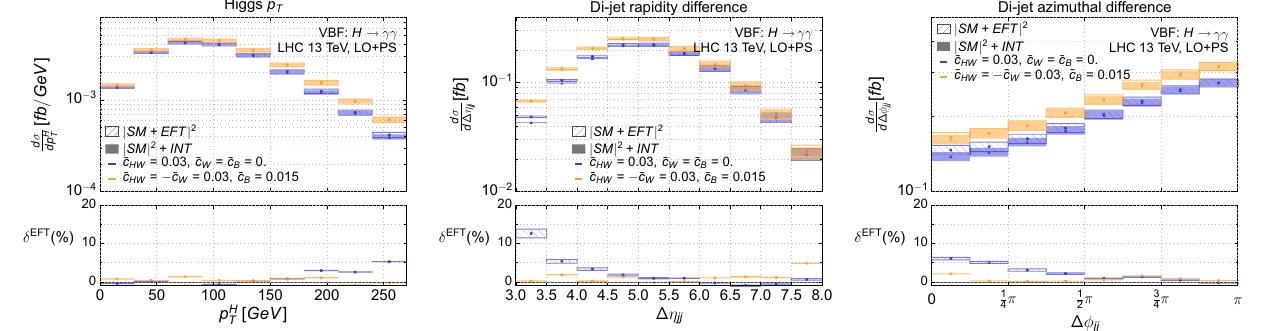
Fig. 3 Same as in Fig. 1, but for VBF Higgs production